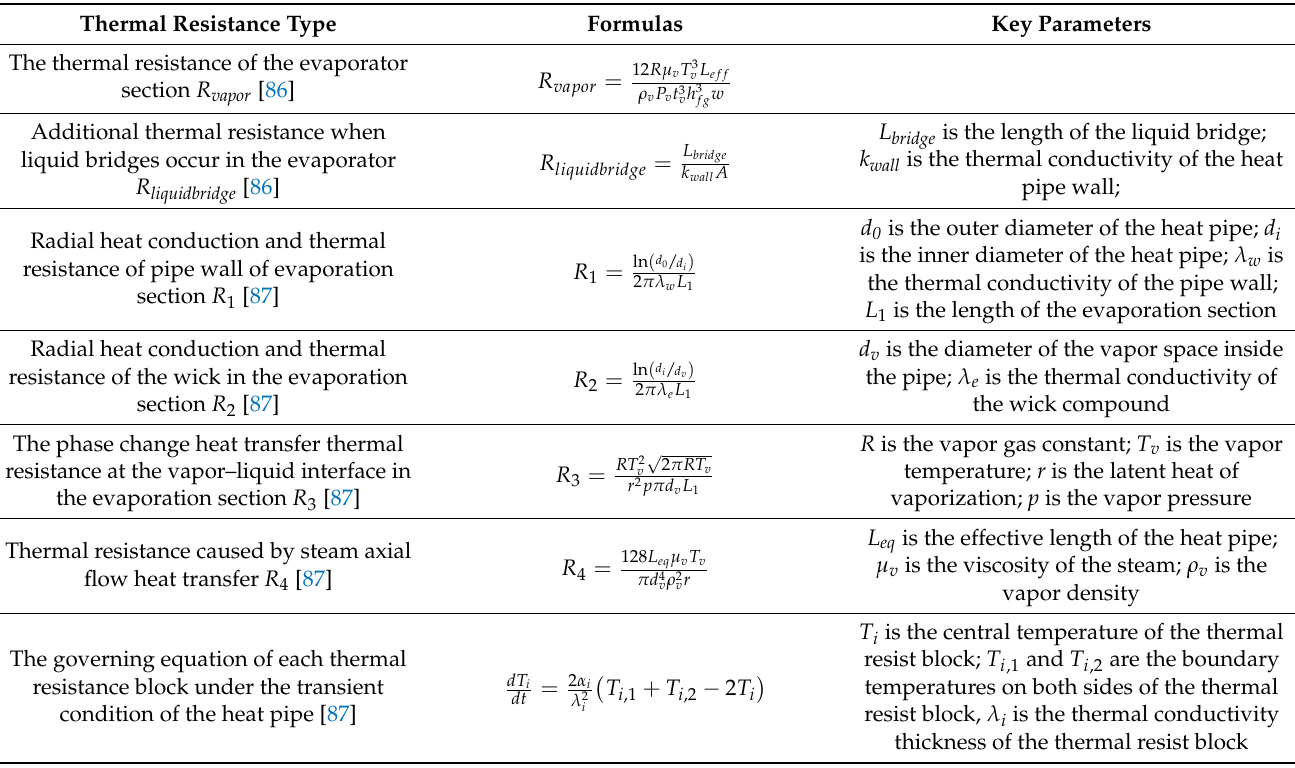
Table 6. Summary of different types of thermal